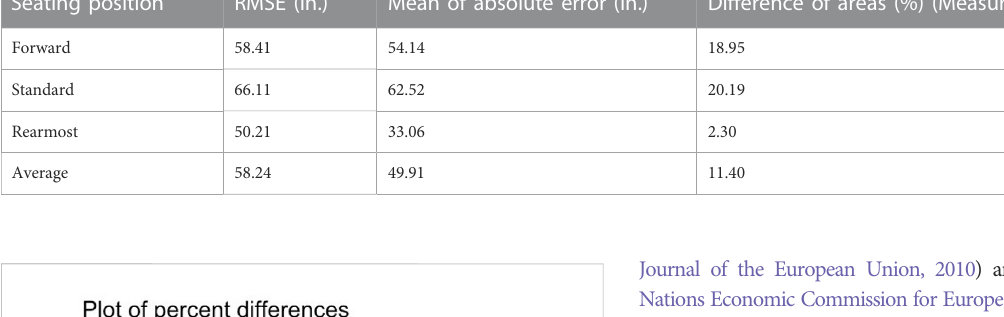
TABLE 1 RMSE, mean absolute error, percent difference in areas. Seating position RMSE (in.) Mean of absolute error (in.)